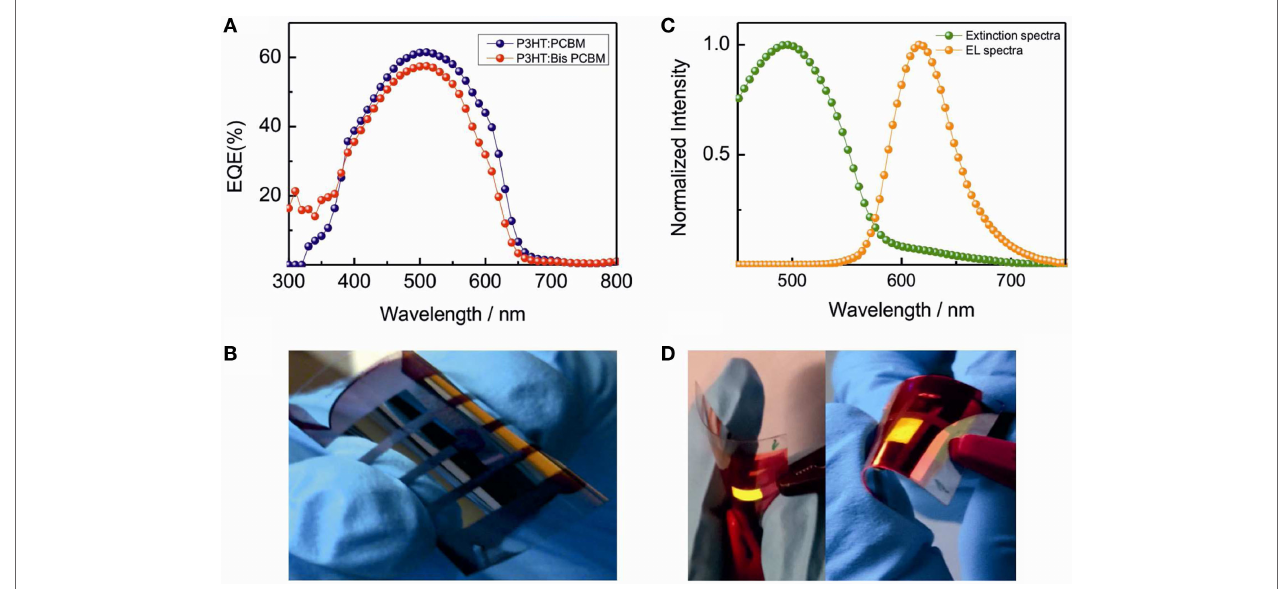
FigUre 6 | (a,B) EQE spectra of the solar cells with PET/ITO/PEI/P3HT:PCBM or bis-PCBM/PEDOT:PSS/Ag, and the photograph of the corresponding flexible solar cell, respectively, and (c) normalized extinction and electroluminescence spectra of the OLEDs with PET/ITO/PEI/ADS200RE/PEDOT:PSS/Ag, and (D) the photograph of the corresponding flexible OLED while operated in air.